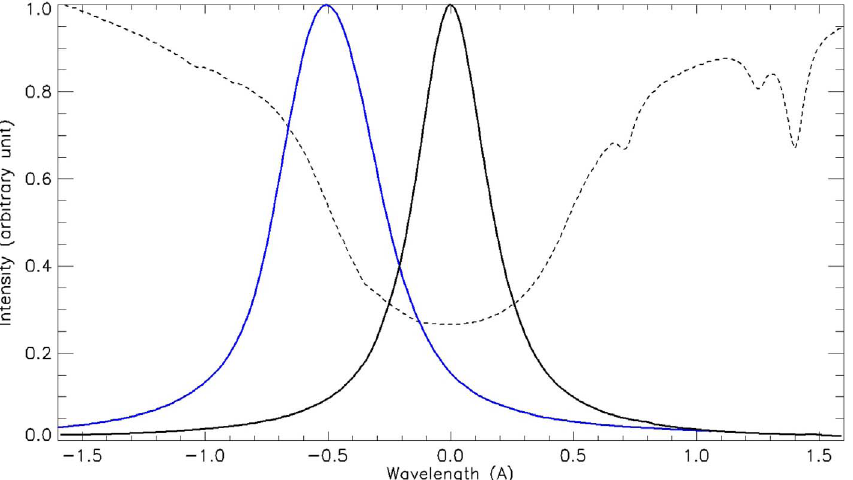
Fig. 3. The transmission curves of the line centered fi lter (black) and of the blue-shifted fi lter (blue) as a function of wavelength. The dashed line is the observed H a line pro fi le.